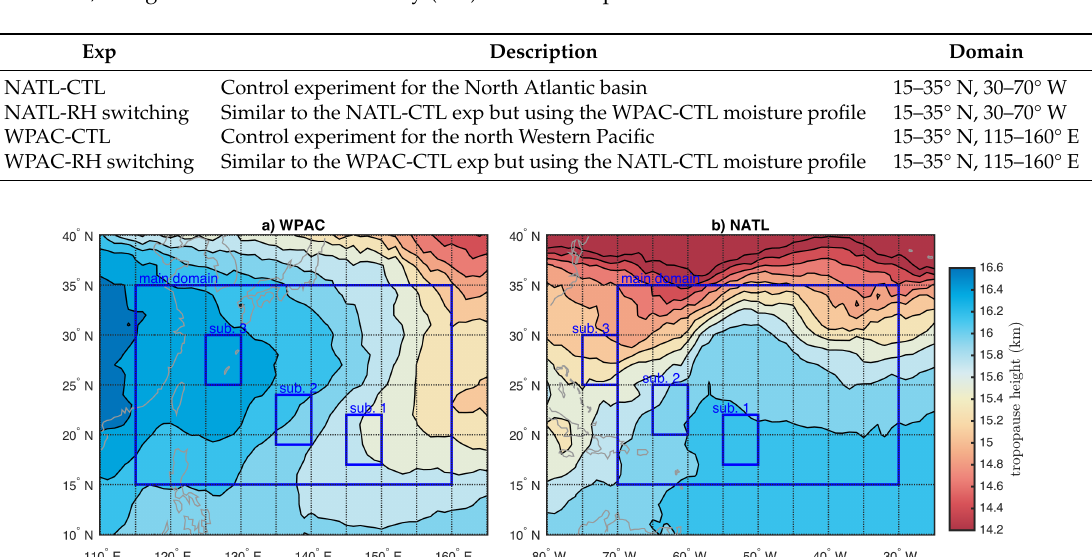
Table 1. Control (CTL) experiments for the Northwestern Pacific (WPAC) and North Atlantic (NATL) basin, along with the relative humidity (RH)-switched experiments.